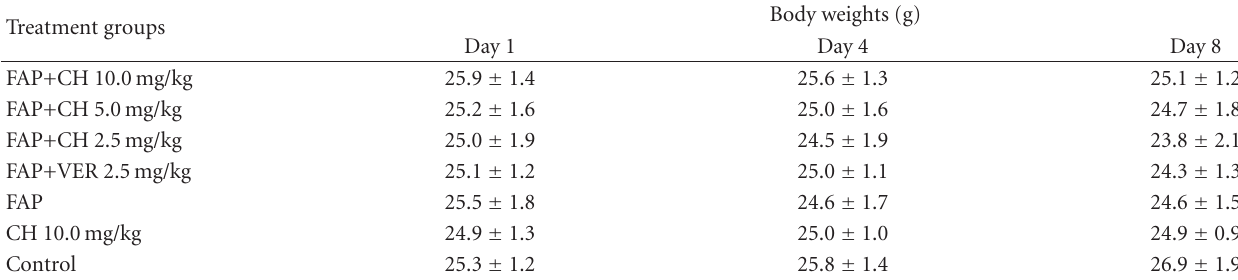
Table 2: Body weights of the animal after